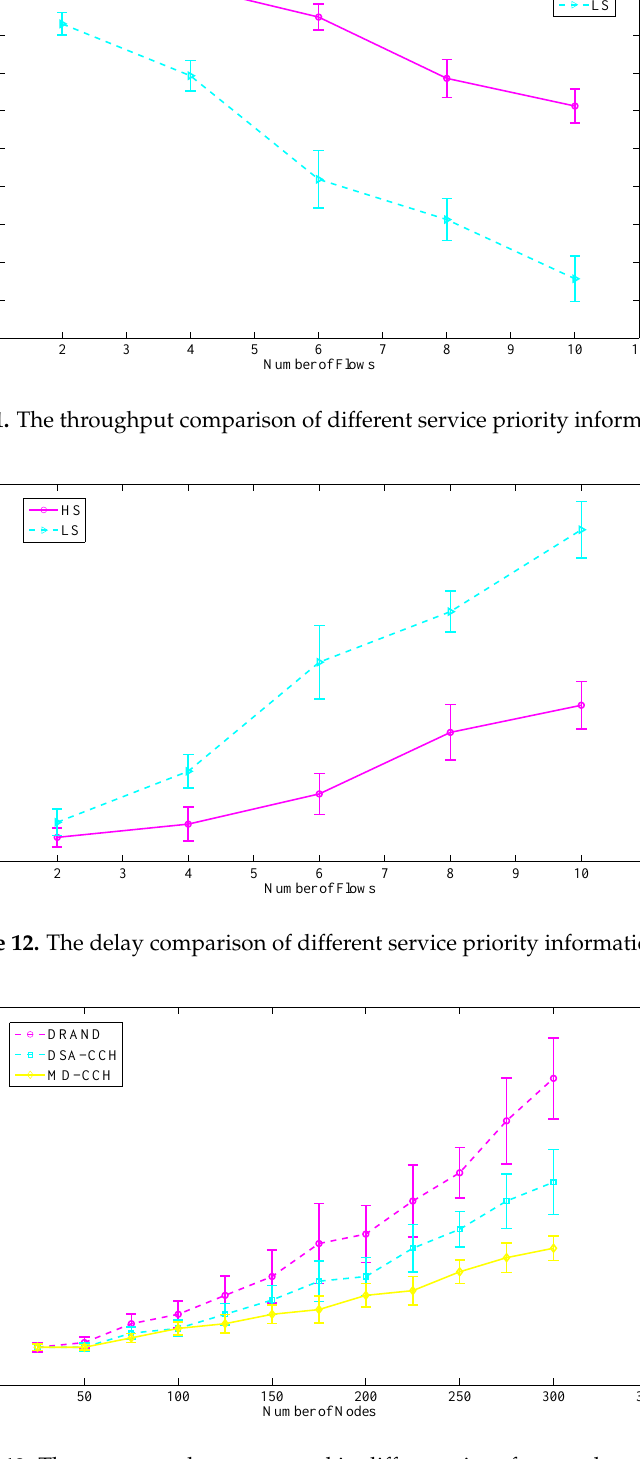
Figure 13. The average colors consumed in different size of network